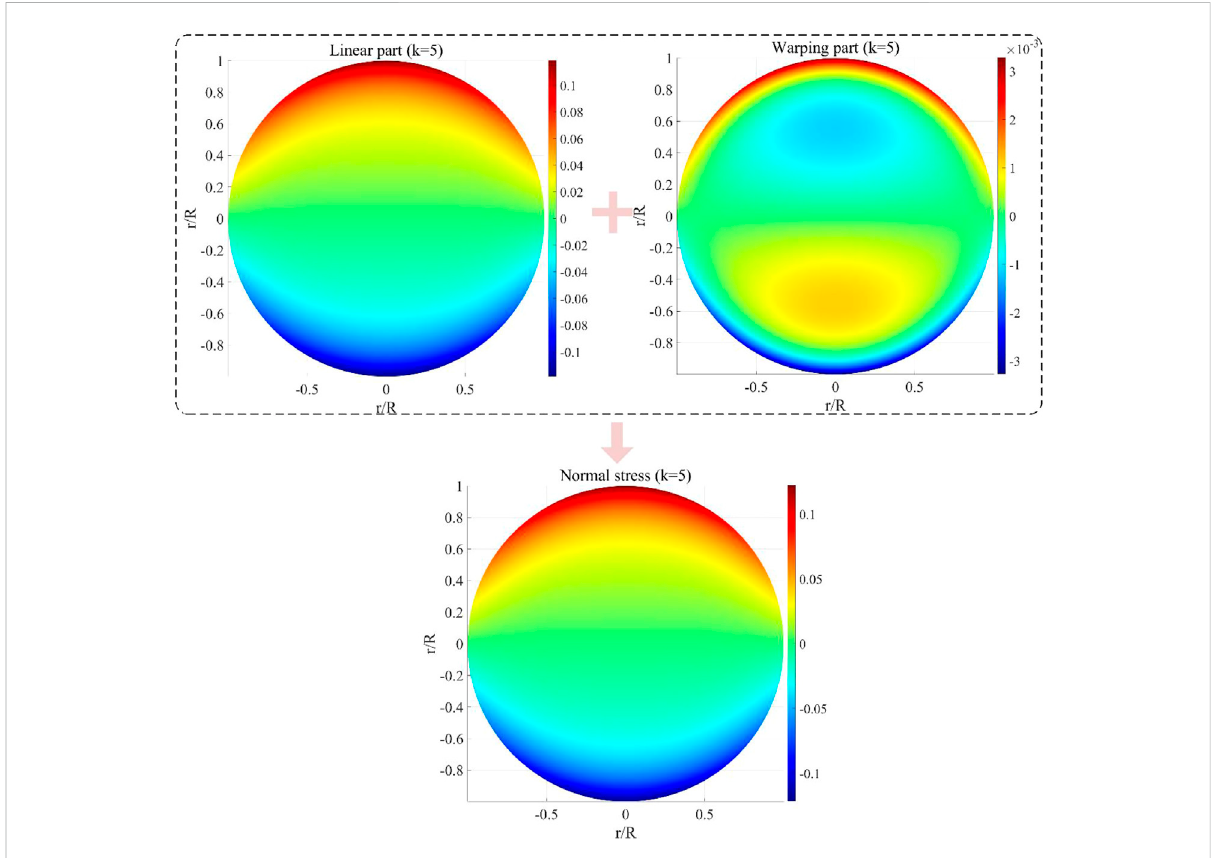
FIGURE 7 The normal stress and its decomposition for k = 5.